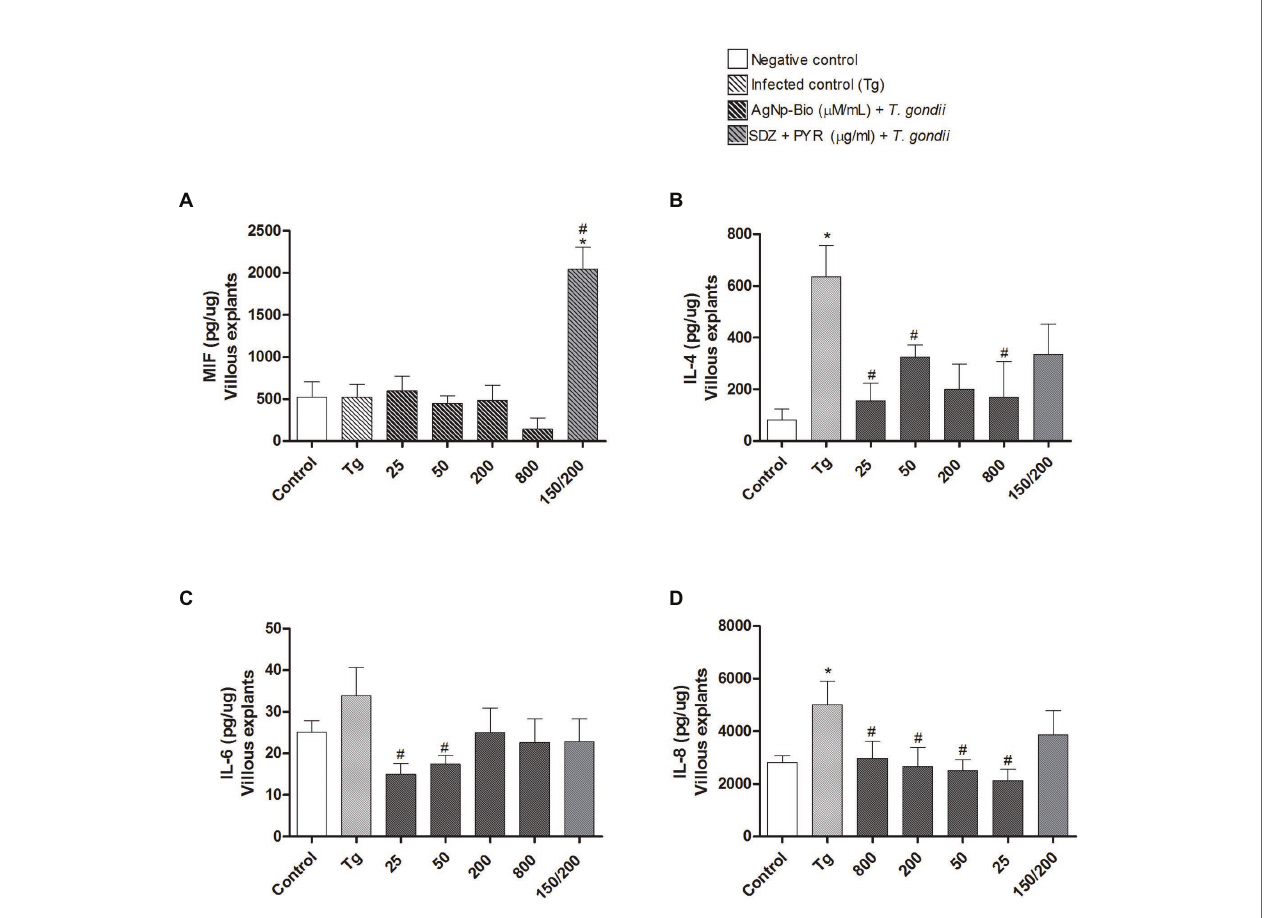
FIGURE 8 | Citokines production by villous explants. Villi were cultured and infected or not with T. gondii for 24 h. After, villi were treated or untreated with different AgNp-Bio concentration or combination of sulfadiazine/ pyrimethamine (SDZ + PYR). After 24 h of treatment, supernatants were collected and the cytokines production was measured by sandwich ELISA. Production of MIF (A) , IL-4 (B) , IL-6 (C) and IL-8 (D) . Data were expressed as pg/ng and shown as mean ± SEM from three independents experiments in nine replicates. Comparison in relation to control (control; * p < 0.05). Comparison in relation to Tg ( # p < 0.05). Differences between groups were analyzed by One-Way ANOVA with the Bonferroni multiple comparison post hoc